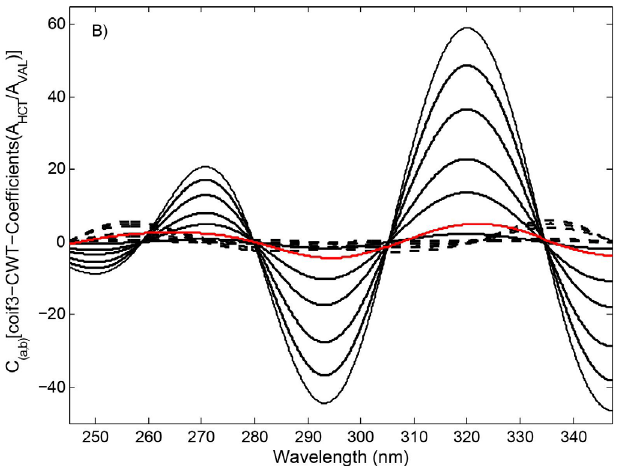
FIGURE 4B - RS-coif3-CWT spectra of VAL (----) : 1.0, 3.0, 9.0, 15.0, 21.0, 27.0, 33.0 µ g/mL and HCT (  ) : 1.0, 6.0, 11.0, 16.0, 21.0, 26.0 µ g/mL and tablet sample (  ) containing 2.50 µ g/mL of VAL and 16.0 µ g/mL of HCT.